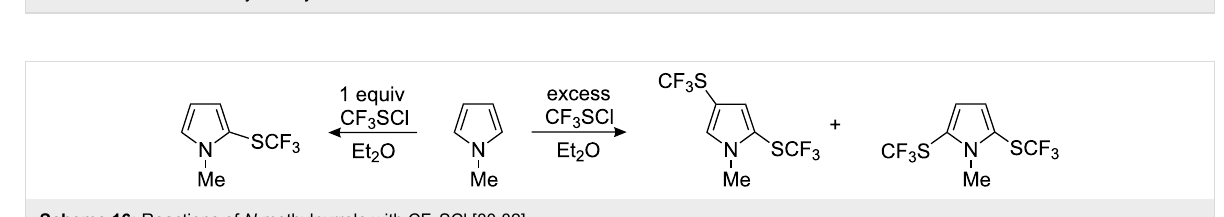
Scheme 15: Trifluoromethylsulfanylation of indole and indolizines.